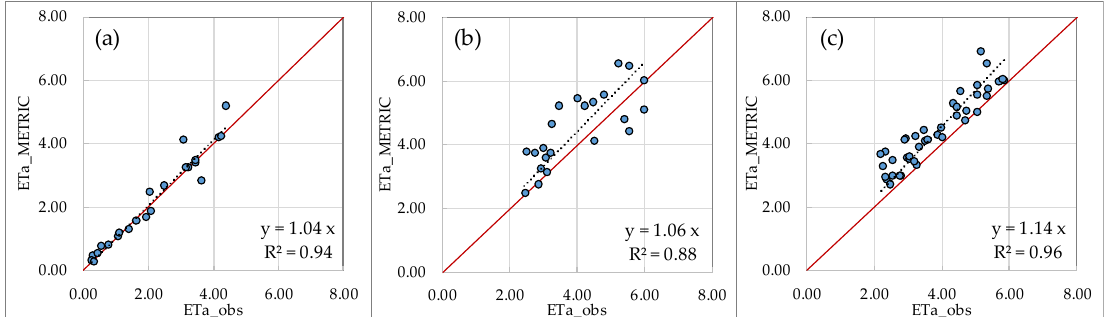
Figure 5. Daily values of crop coefficient estimated by METRIC (Kc _METRIC ) and observed by the eddy covariance system (Kc _ec ) in the June 2005 and July 2006 sugarcane cycles at USR site. Shaded areas separate the phenological stages of ( a ) germination, ( b ) tillering, ( c ) growth, and ( d ) maturation. DAP = days after planting.